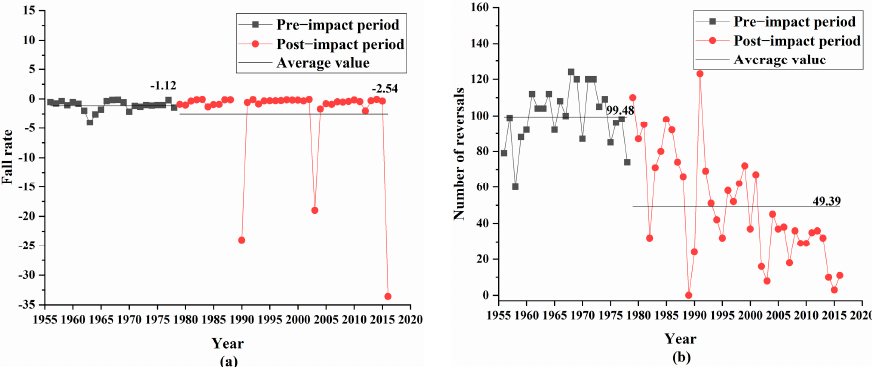
Figure 13. Fall rate ( a ) and number of reversals ( b ).